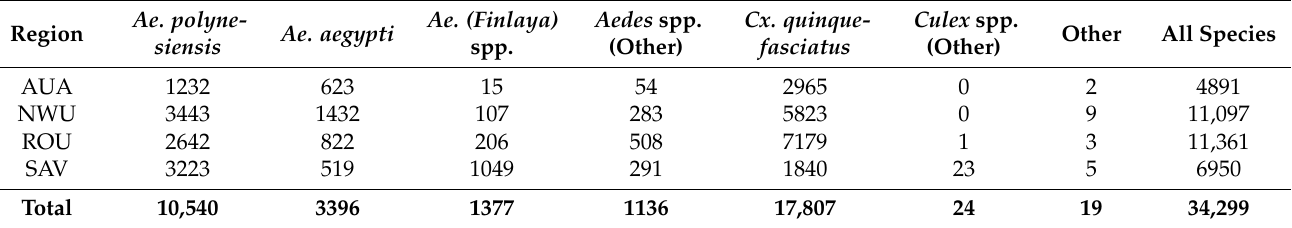
Table 2. Number of female mosquitoes caught by species category and region, Samoa 2019.